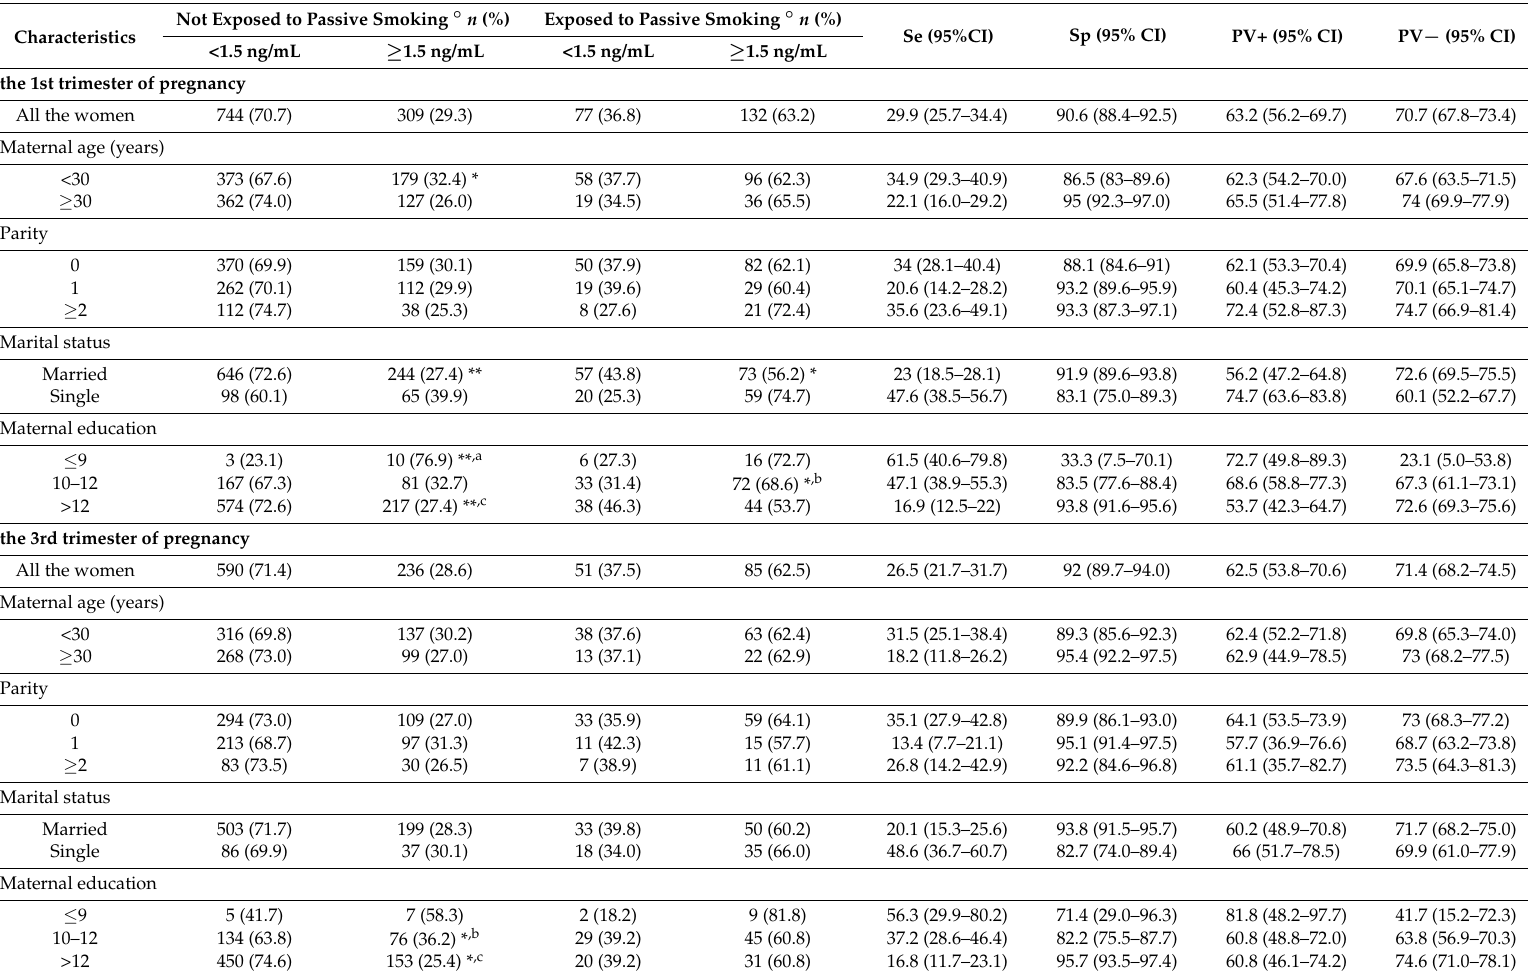
Table 5. Sensitivity (Se), specificity (Sp), positive and negative predictive values (PV+, PV − ) according to the saliva cotinine cut-off of 1.5 ng/mL.